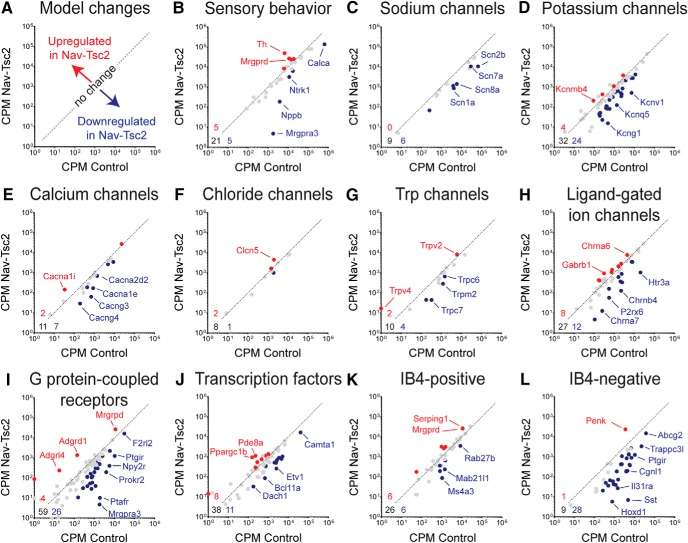
Tsc2 is required for full expression of ion channels and markers of IB4-negative DRG neurons. A, Model of expression changes in Nav-Tsc2 mice. B–L, Scatterplots of normalized counts in control and Nav-Tsc2 mice for candidate genes involved in sensory behavior (B), ion channels (C–H), G protein-coupled receptors (I), transcription factors (J), and the most enriched genes in IB4-positive (K) and IB4-negative (L) neurons expressing Nav1.8-Cre (Chiu et al., 2014). Red and blue points denote upregulated and downregulated genes, respectively, in Nav-Tsc2 DRG compared to control (adjusted p < 0.05, log2 fold change >0.5 or <-0.5). Gray points denote no change in expression. Gene lists and values can be found in Extended Data Figure 7-1. Select genes that were highly differentially expressed in each category are highlighted. Numbers in bottom left corner of panels denote number of upregulated (red), downregulated (blue), and unchanged (black) genes analyzed. Dotted line is representative plot of y = x for reference purposes only.